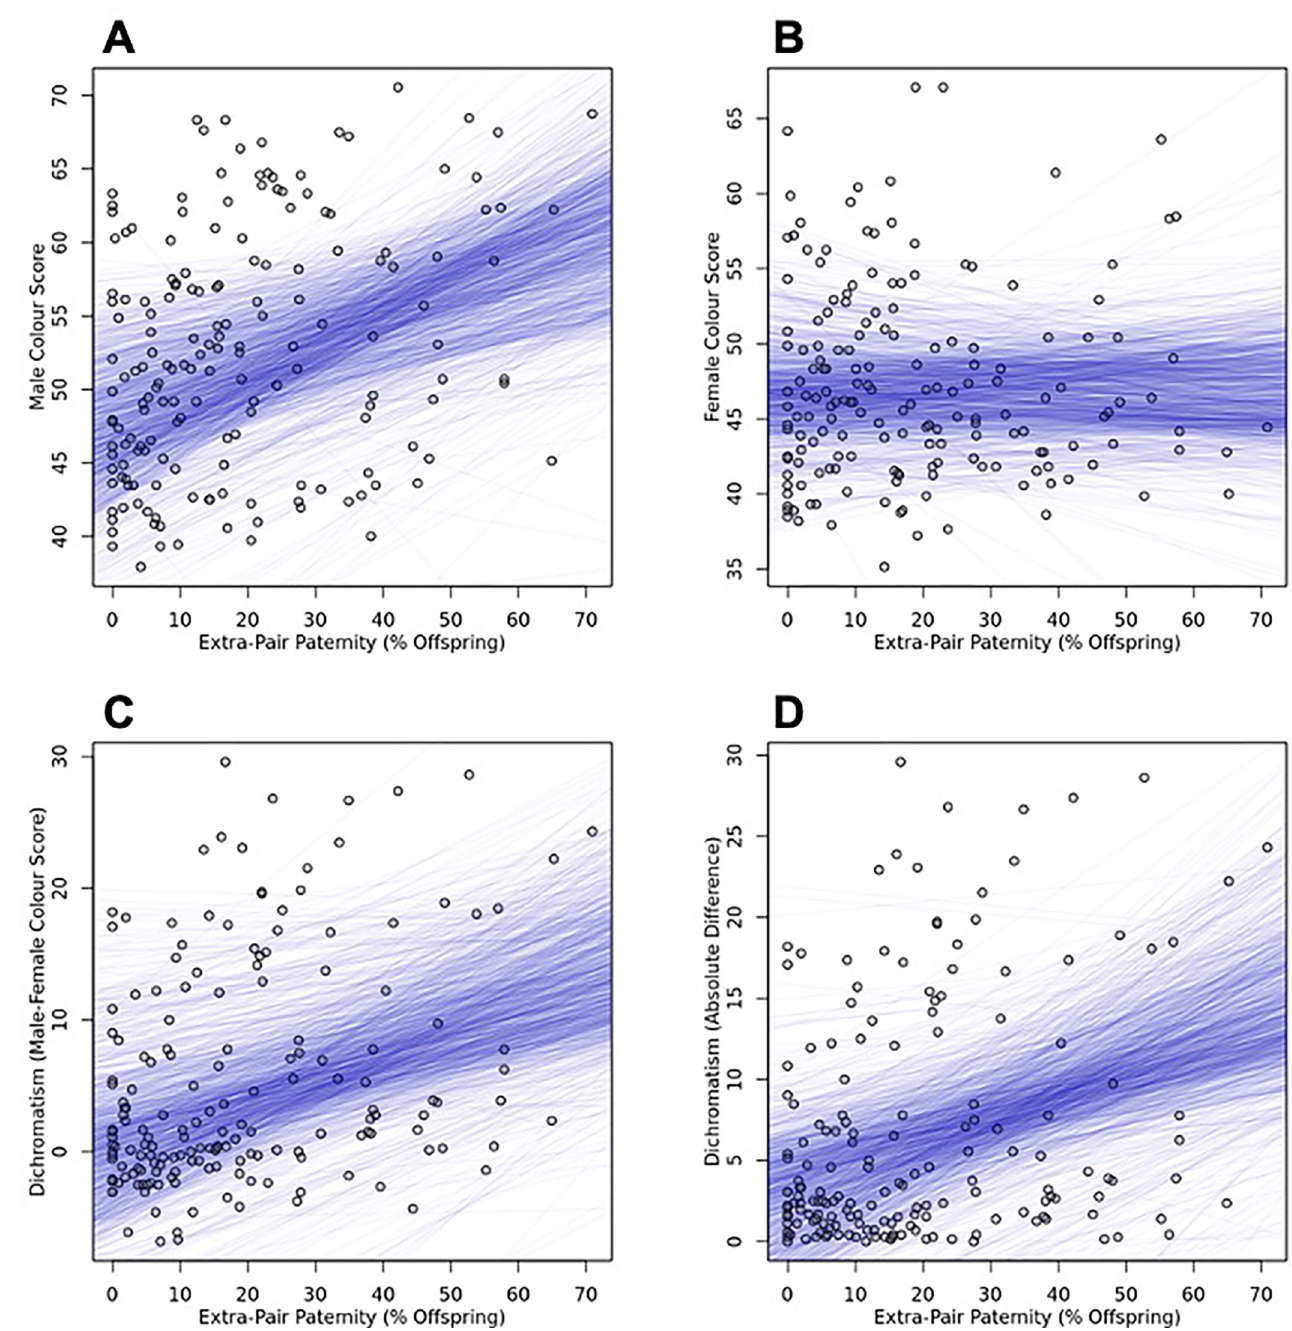
Fig 1. Rates of extra-pair paternity are positively associated with male colour scores (A), sexual dichromatism (C), and the absolute value of sexual dichromatism (D), but not female colour scores (B). Each figure shows the posterior distribution of GLS lines from the 1000 GLS models corresponding to the Hackett